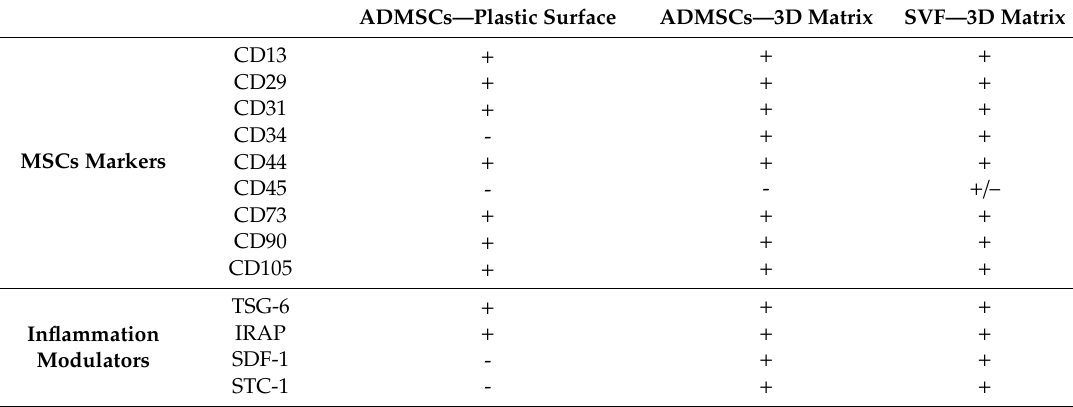
Table 4. Phenotypic characterization of ADMSCs and adipose tissue-derived SVF by